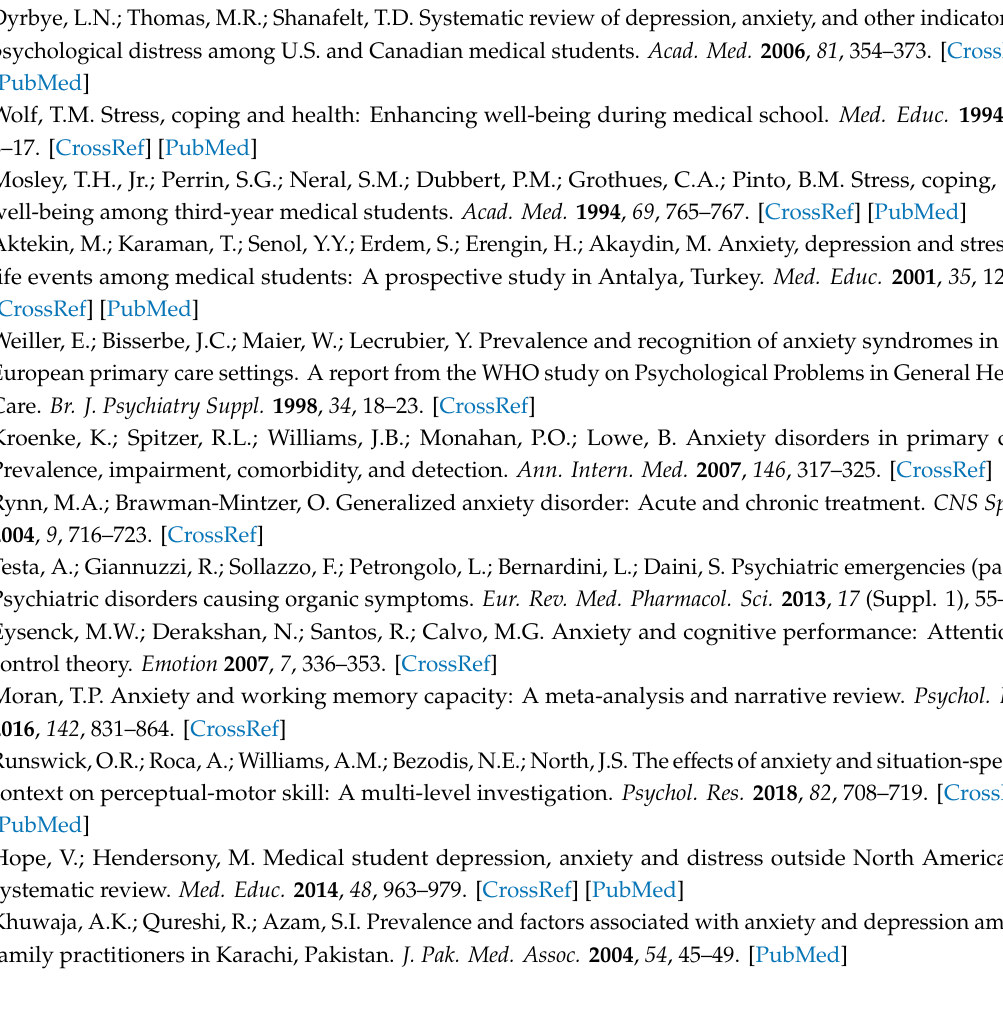
Figure S1: Preferred Reporting Items for Systematic Reviews and Meta-Analyses (PRISMA) checklist, Table S1: Mean age, proportion of female medical students and proportion of single medical students in sixty-nine studies examining anxiety in medical students, Table S2: Quality Appraisal & Ethical Approval of 30 studies examining prevalence of anxiety in medical students, Table S3: Prevalence rate of anxiety stratified by gender as reported by twenty-four studies examining anxiety in medical students, Table S4: Prevalence rate of anxiety stratified by pre-clinical or clinical year of study reported by twenty-five studies examining anxiety in medical students, Table S5: Comparison of prevalence rate of anxiety between medical students and non-medical students as reported by eight